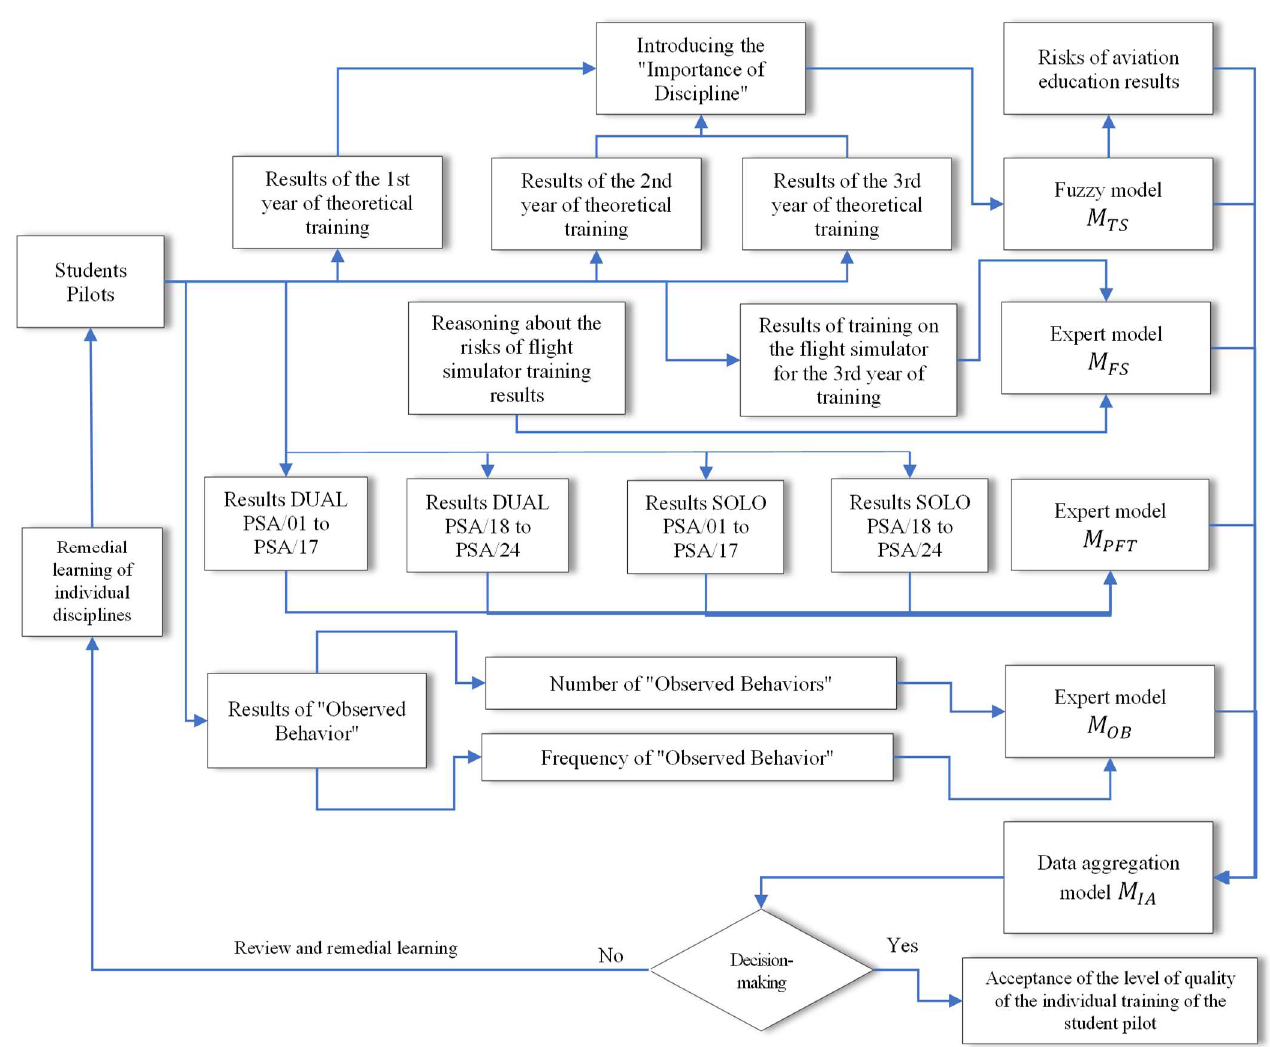
Figure 1. Structural diagram for evaluating the learning outcomes of students (pilots).